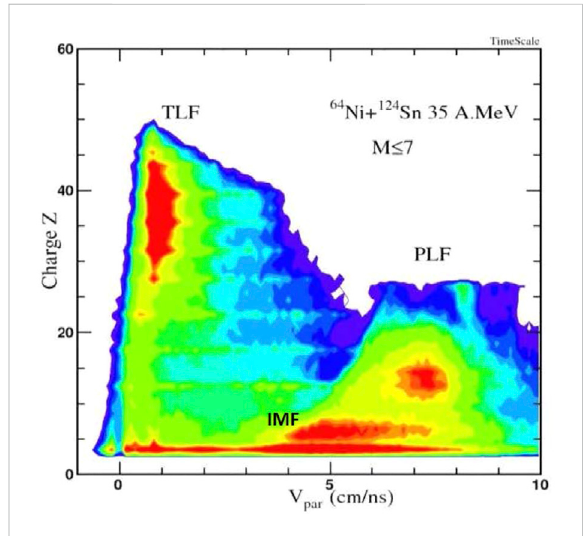
FIGURE 1 Typical correlation between the atomic number and velocity for the PLF, TLF, and IMF fragments.